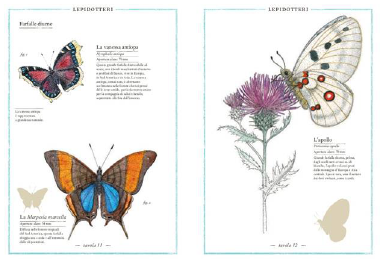
Figure 9. Tchoukriel J.; Aladjidi V., Inventario illustrato degli insetti ; Ippocampo, Italia 2013, [9].